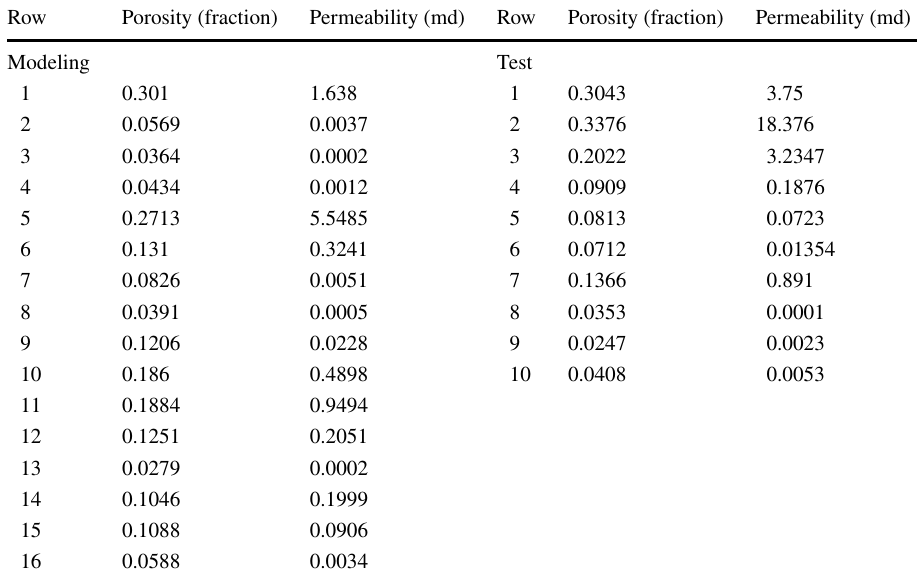
Table 1 Porosity and permeability of samples